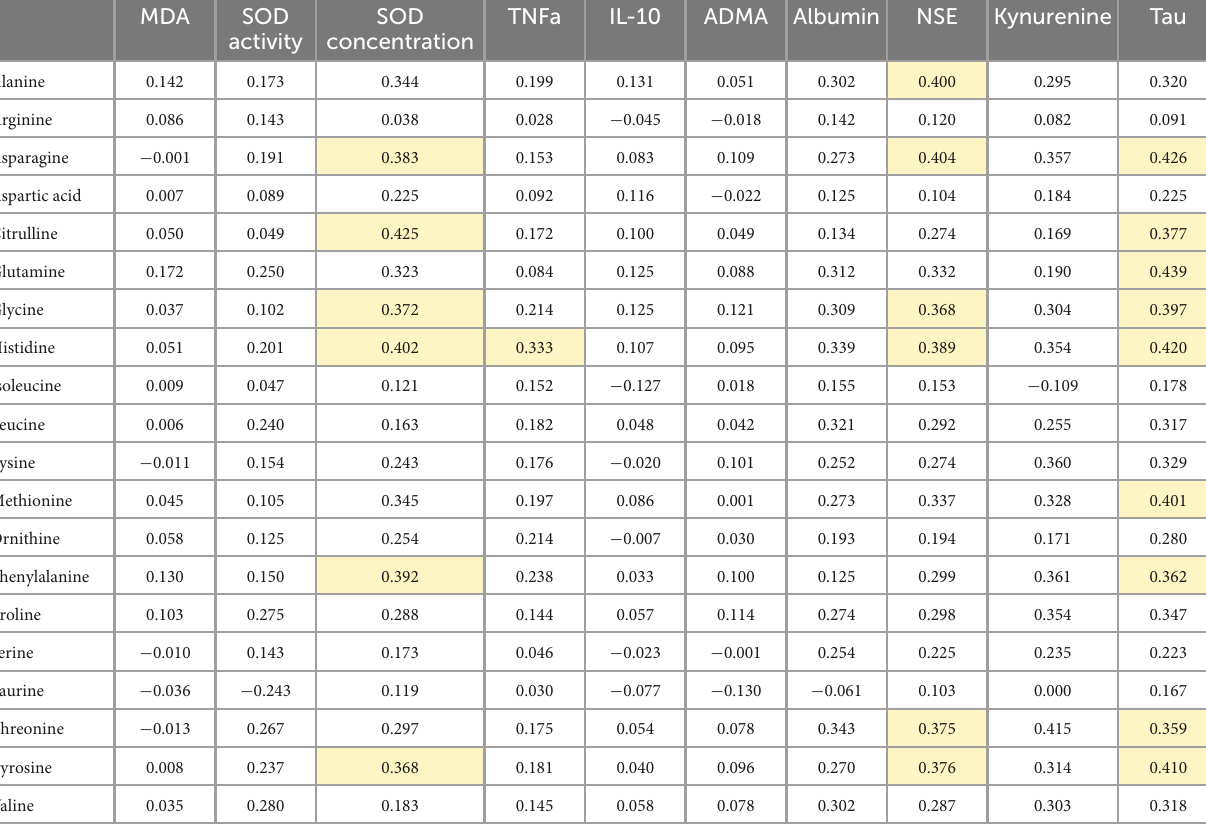
Spearman correlation coefficient between plasma amino acids and markers in CSF. Relationships significant after adjustment for multiple testing (200 comparisons, p < 0.00025) shaded. CSF, cerebrospinal fluid; MDA, malondialdehyde, SOD, superoxide dismutase, TNF α , tumor necrosis factor alpha; IL-10, interleukin 10; ADMA, asymmetric dimethyl arginine; NSE, neuron